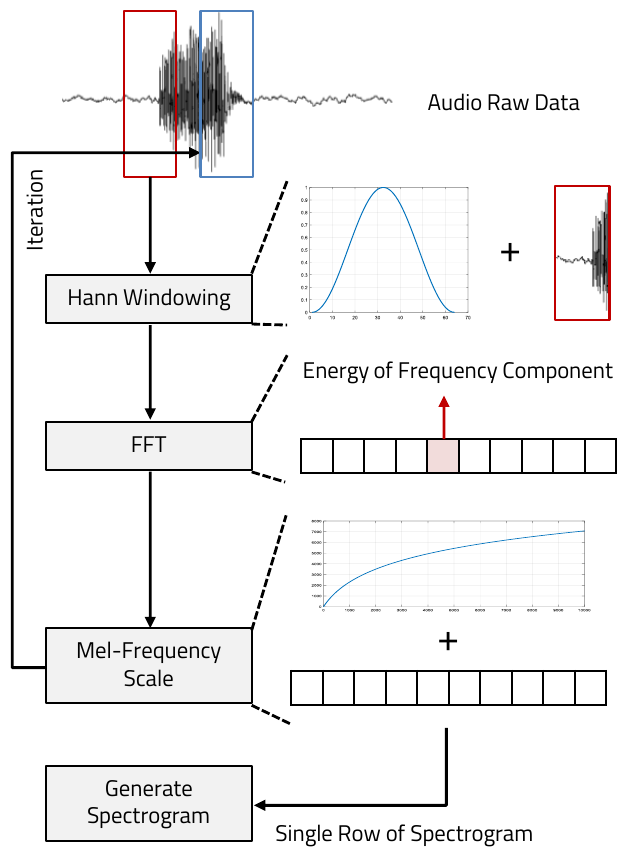
Figure 4. Overview of the audio data preprocessing to generate a